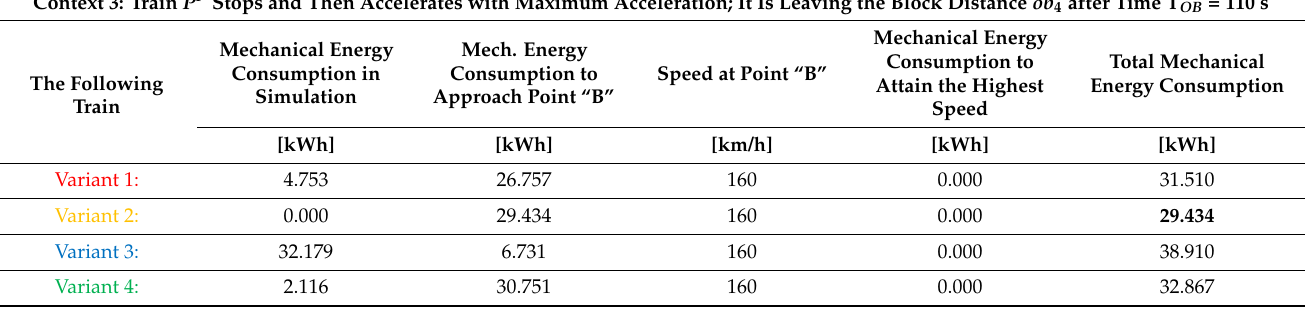
Table 7. Standardization of results for Context 3.